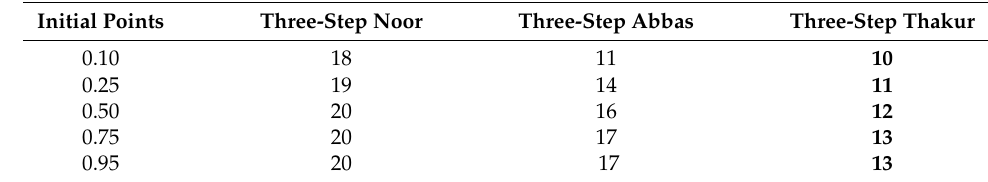
Table 3. When a k = k , b k = k + 3 Number of Iterates Required to Reach Fixed Point .